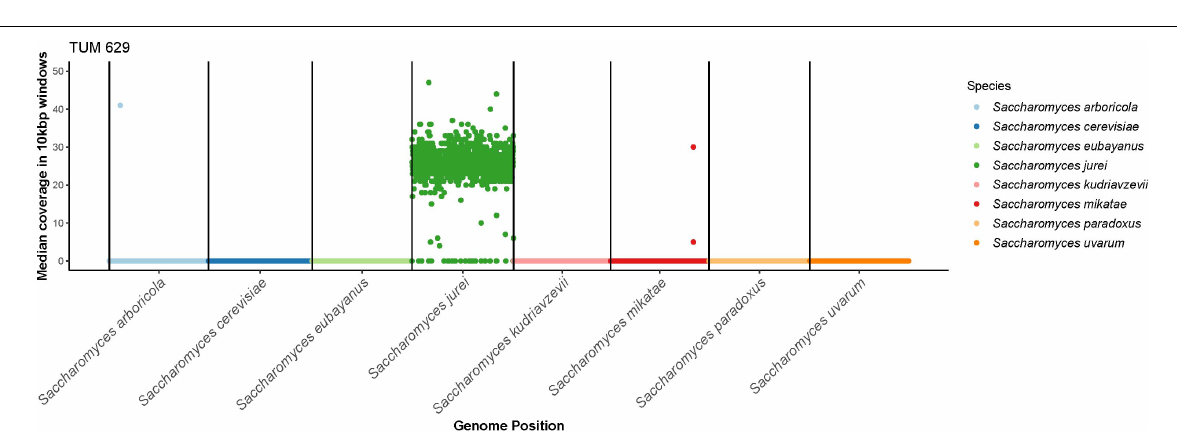
Frontiers in Microbiology |